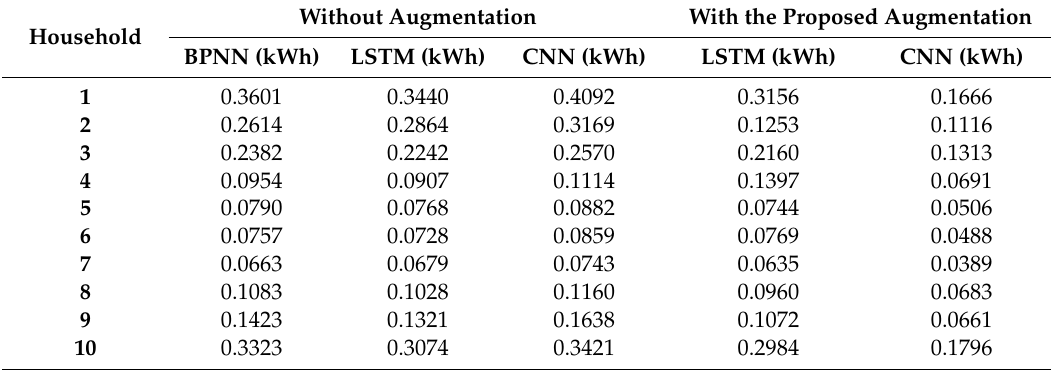
Table 4. Load Forecasting results (root mean square error (RMSE)) with and without proposed